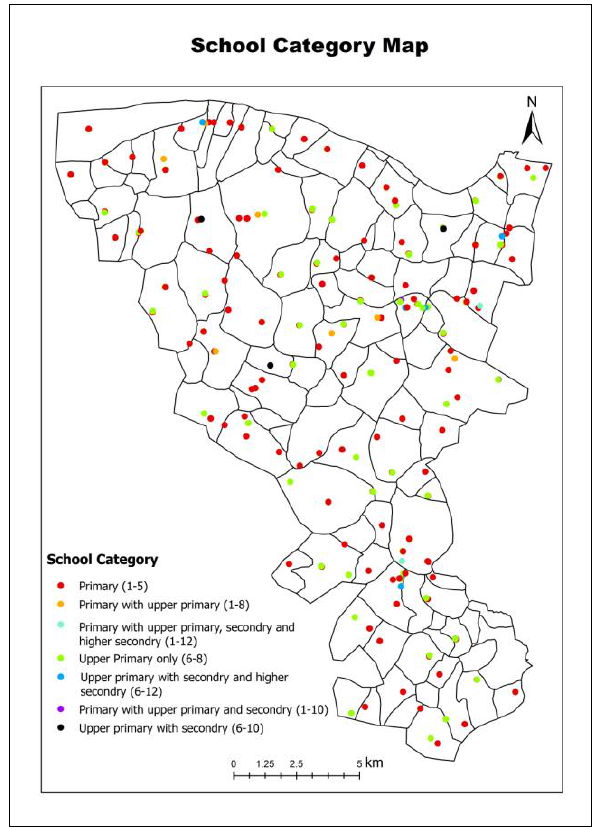
Figure 7. Map showing the category of each school assigned on the basis of class